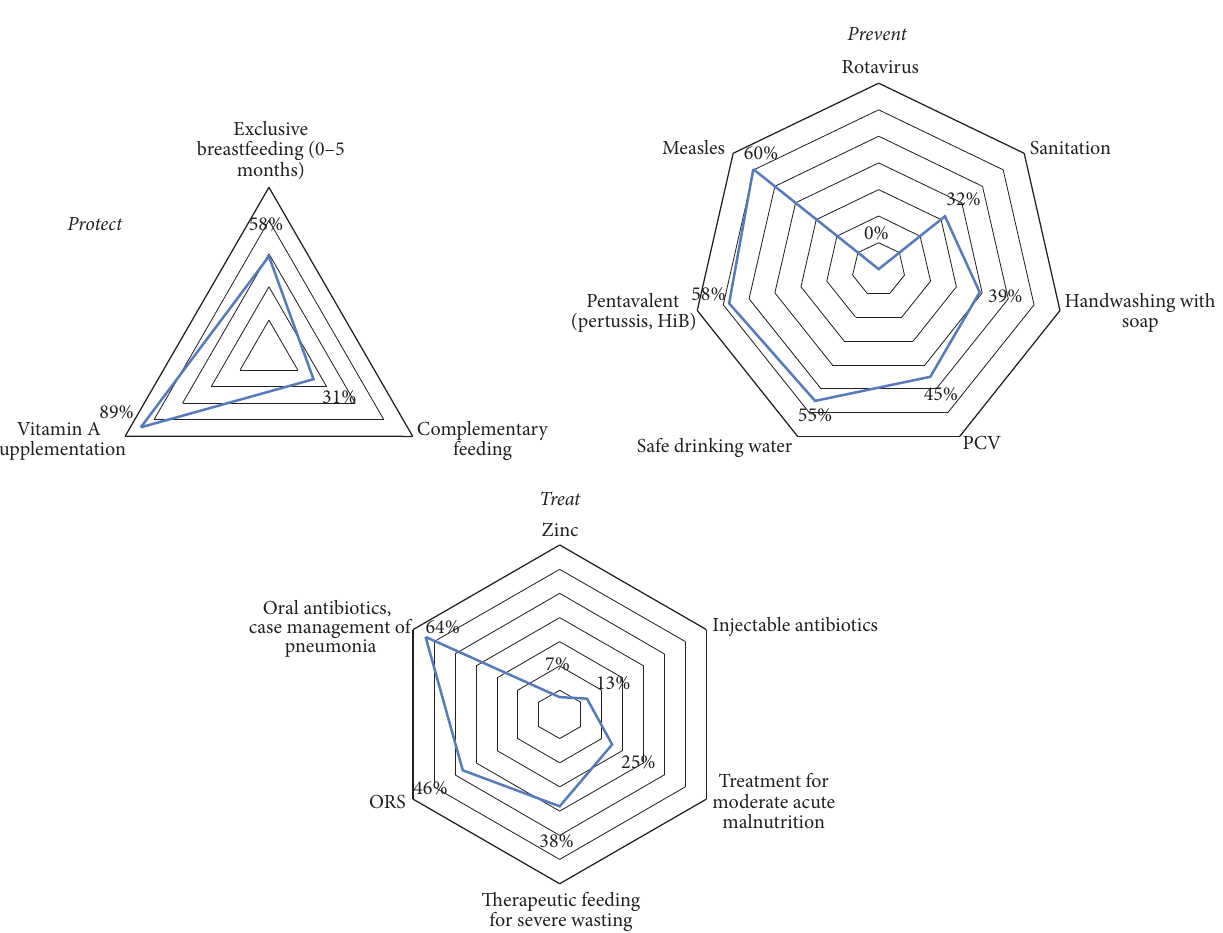
Figure 1: Baseline coverage levels in Afghanistan for interventions to protect, prevent, and treat pneumonia and diarrhoea, included in LiST.